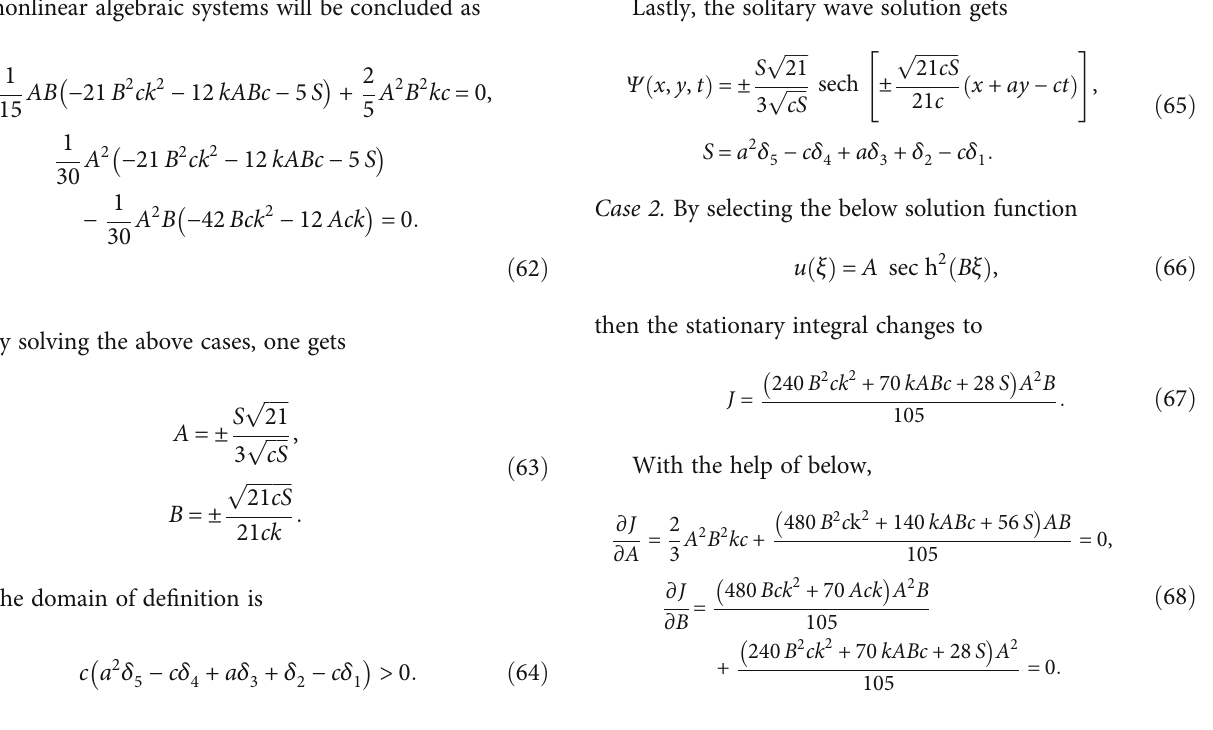
= : 5, a = 1 : 5, a = 2, a = 1, Ω = 1 : 9, Ω 1 2 3 4 2